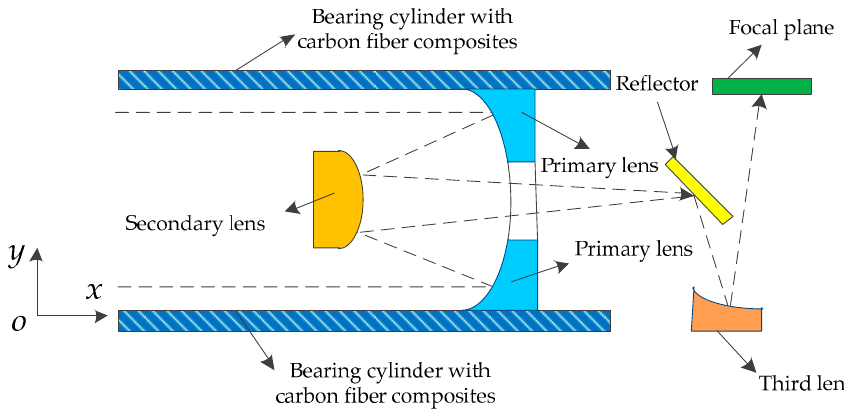
Figure 1. Simplified optical system schematic of a space optical remote sensor. The dashed line indicates the way of light.